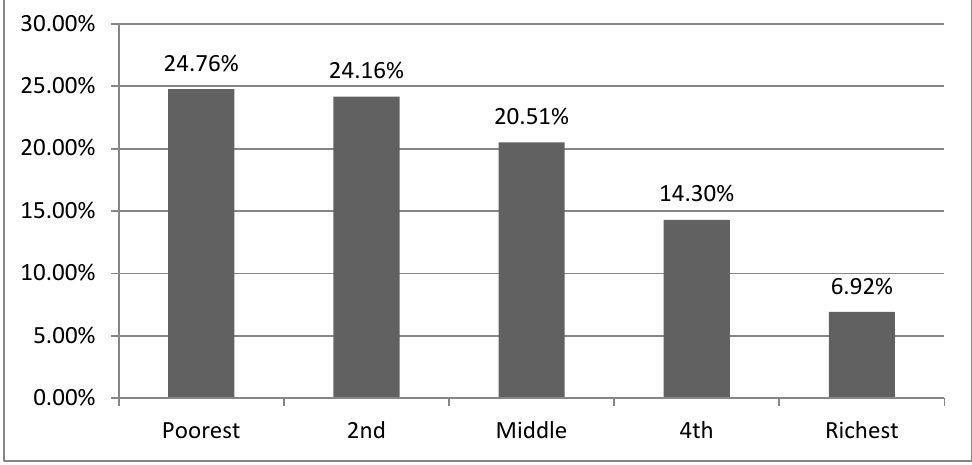
Figure 2. The distribution of Askeskin enrollees across different income level